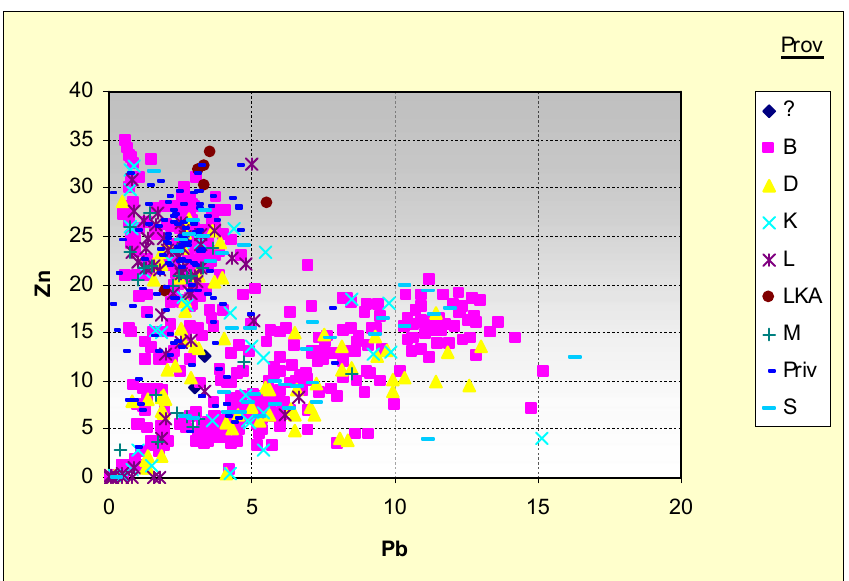
Figure 9. Zinc content (M%) as a function of lead content (M%) determined by AAS for bronze and brass objects of presumable and certain Benin provenance (Rathgen Research Laboratory Database.